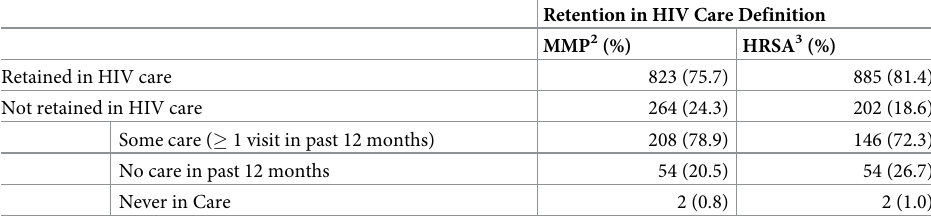
Table 3. HIV care as documented in the medical record for Case-Surveillance-Based Sampling respondents, 2012, 2013, and 2014 (N = 1087 1